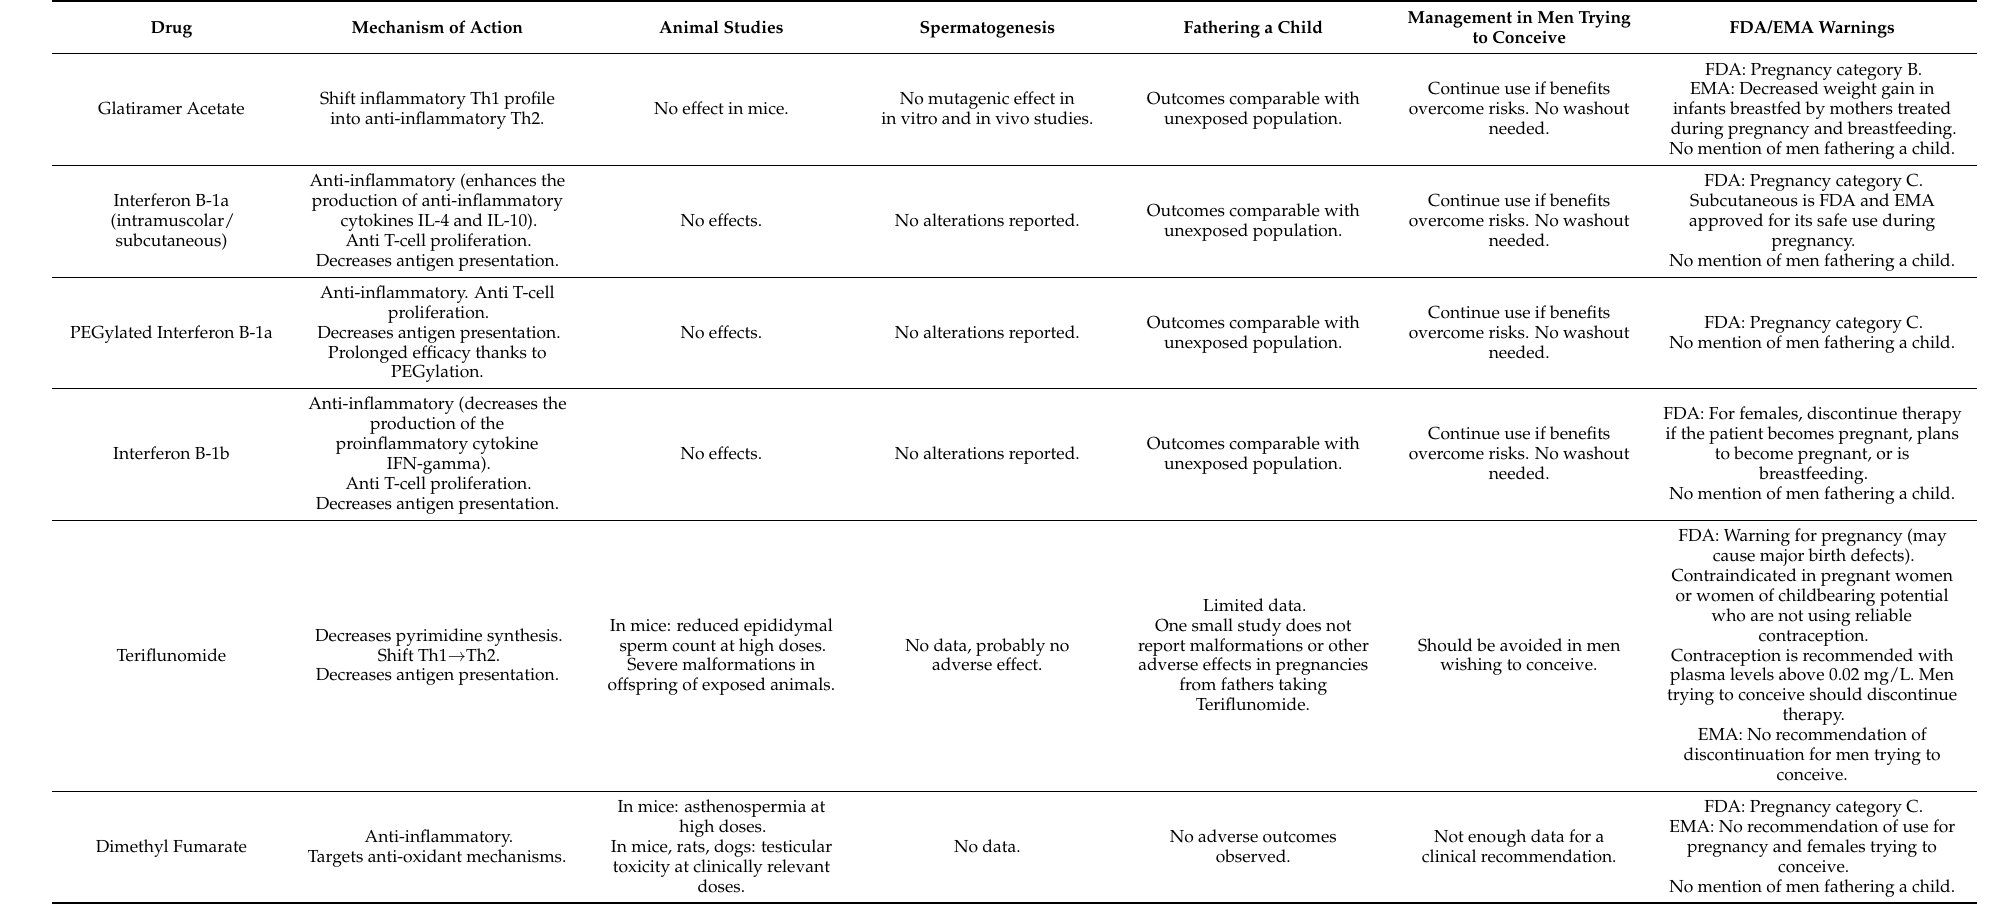
Table 2. Summary of potential gonadotoxicity of disease-modifying therapies (DMT) for multiple sclerosis in